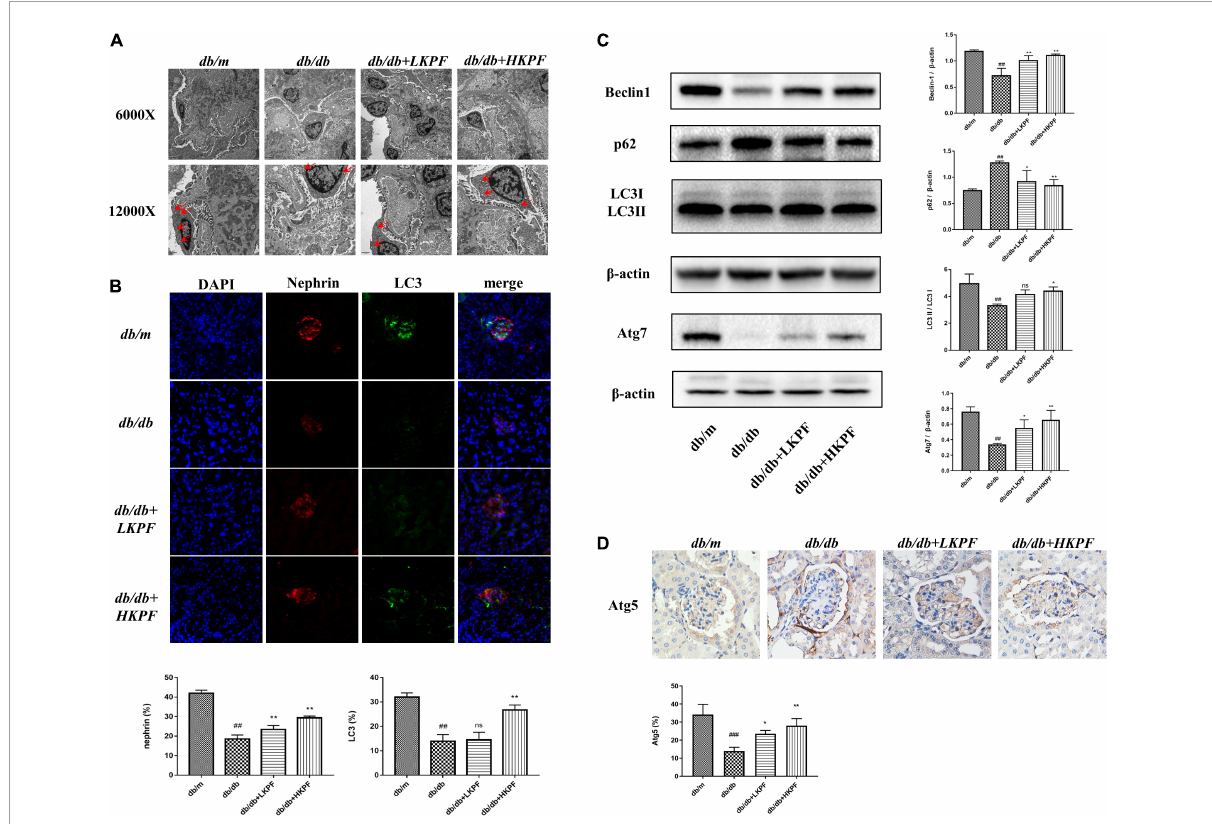
FIGURE5 Kaempferol enhanced autophagy in podocytes in the kidneys of db/db mice. (A) Autophagosome formation was detected in kidneys by using TEM (6000 × , bar = 2 µ m and 12000 × , bar = 1 µ m), red arrows indicated autophagosomes. (B) IF analysis of the autophagosome marker LC3II and podocyte marker protein nephrin in kidney tissue. The tissues were stained with antibodies against LC3II (green) and nephrin (red). DAPI (blue) was used to stain the cellular nucleus (400 × , n = 5). (C) WB assay and quantitative analysis of p62, Beclin1, LC3, and Atg7 expressions after Kaempferol treatment, β -actin was used as internal references; data from each group are expressed as the mean ± SD ( n = 3) from three repeated WB experiments. (D) IHC assay and quantitative analysis of apoptosis-related protein: Atg5 (400 × , n = 3). # p < 0.05, ## p < 0.01 and ### p < 0.001 vs. db/m mice; *p < 0.05 and **p < 0.01 vs. db/db mice; ns, not significant). TEM, Transmission electron microscopy; IF, Immunofluorescence; WB, Western